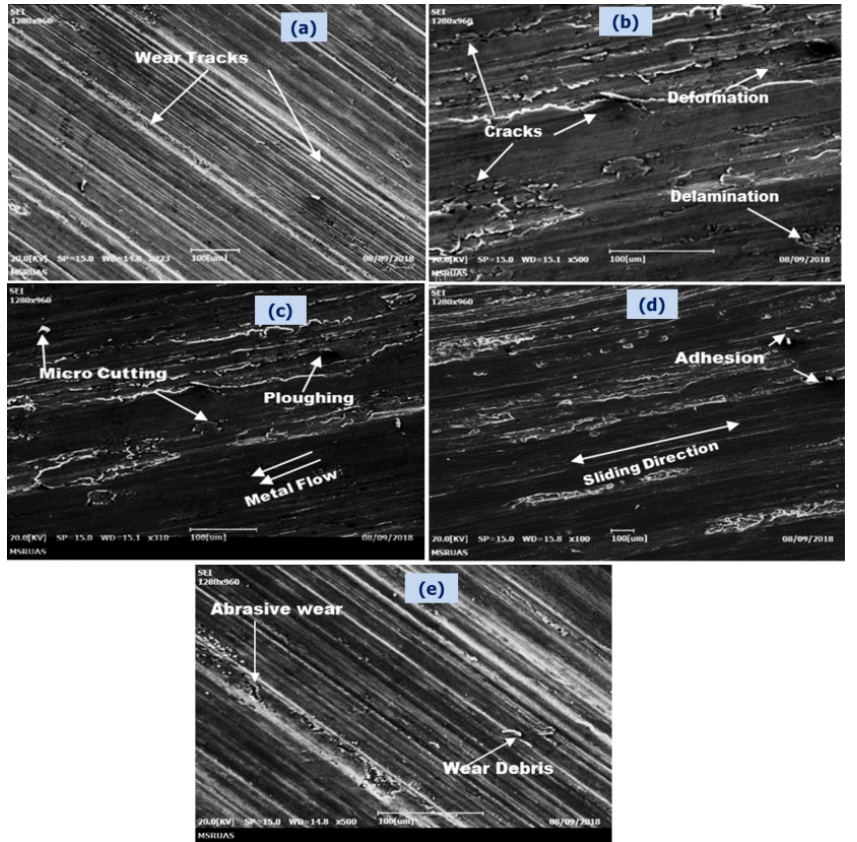
Figure 10. Worn-out SEM photographs of Al6061 alloy and its TiC MMCs after sliding a distance of 6.0 km, with a velocity of 2.62 m/s, at an applied load of 60 N: ( a ) Al6061 alloy; ( b ) Al6061-2 wt.% TiC; ( c ) Al6061-4 wt.% TiC; ( d ) Al6061-6 wt.% TiC; and ( e ) Al6061-8 wt.% TiC.